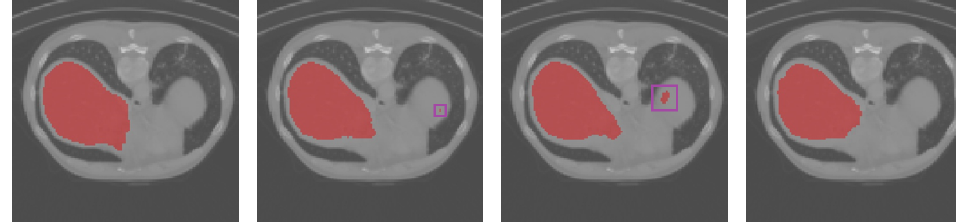
Figure 5. Qualitative results obtained for the liver CT images. From left to right: ground truth, U-Net, Att-UNet, and